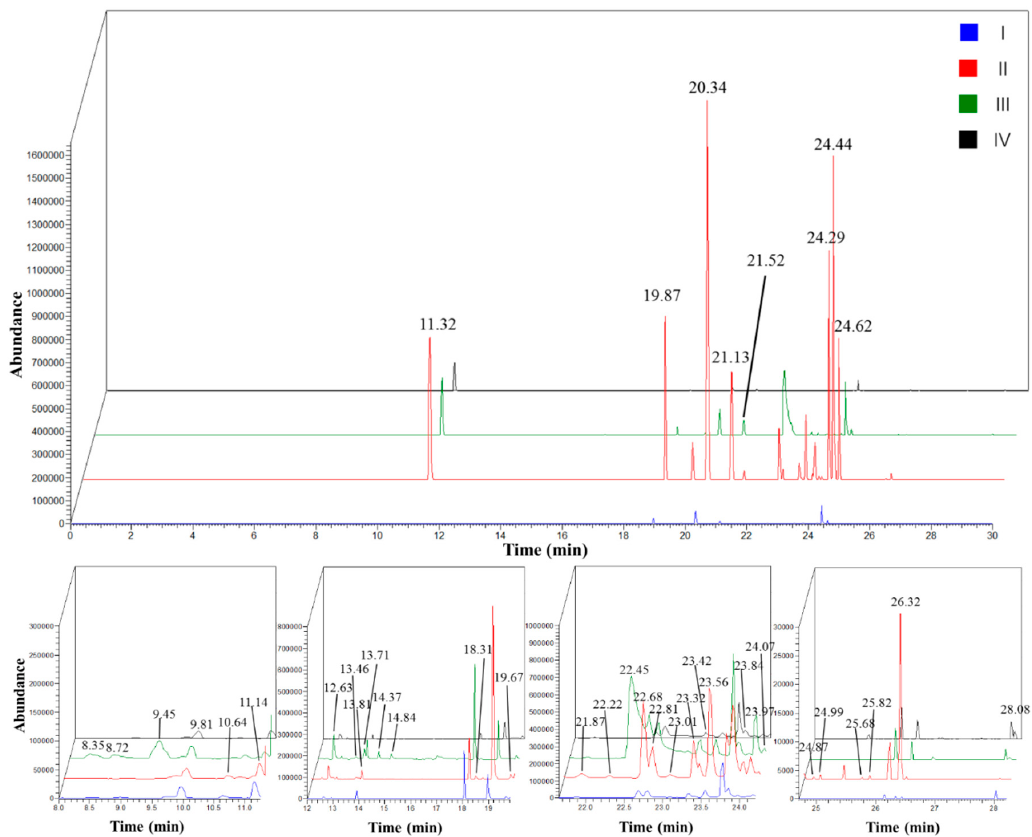
Figure 3. Total ionic chromatogram of scent components emitted from the flowers of L. yunnanensis in different